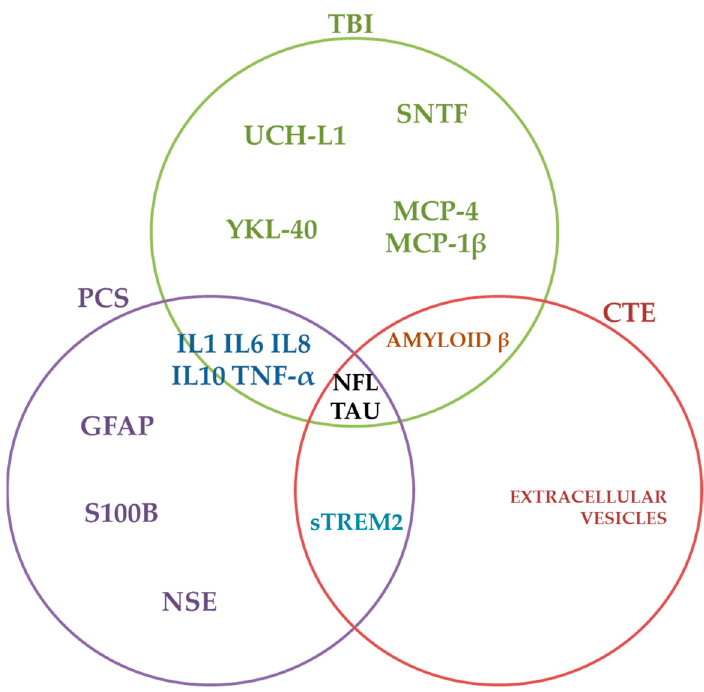
Figure 2. Summative schematization of fluid biomarkers in concussion ‐ related disorders.